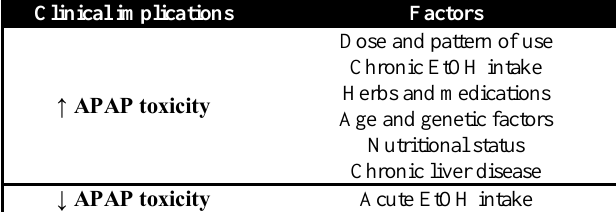
Table 1: Factors influencing APAP-related hepatotoxicity. APAP: Acetaminophen; EtOH: Ethyl